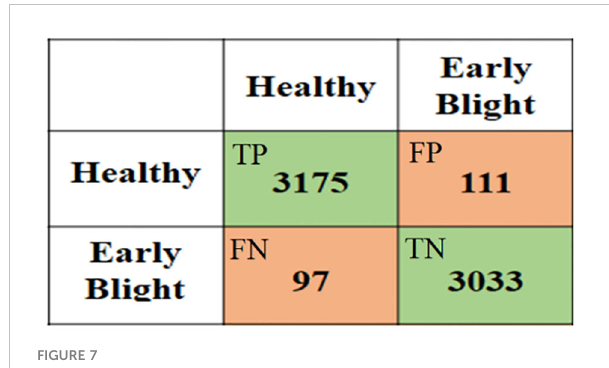
FIGURE 7 An example of a confusion matrix where the rows show the predicted results while columns represent actual classes.